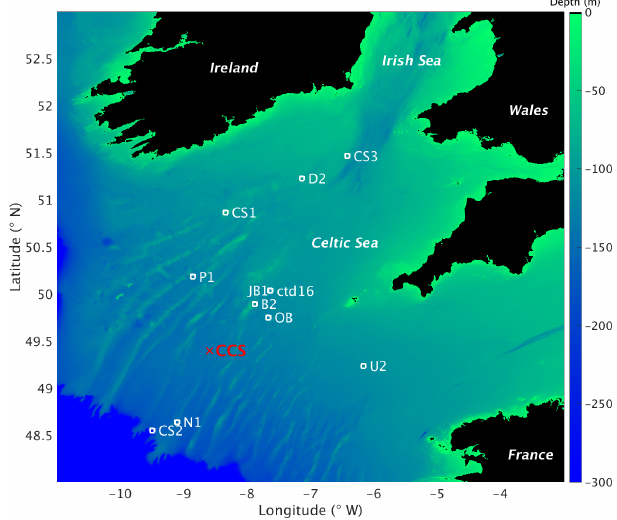
Figure 2. Map of study area and stations for the JR98 and CD173 cruises, including the CCS location (in red colour). The image was created with MATLAB using the repository data for gridded bathymetry provided by General Bathymetric Chart of the Oceans (GEBCO). Bathymetric data are only considered for the shelf sea region (0 to 300m depth) with open ocean depth neglected (deeper than 300m). Continents considered in black colour (over 0m eleva-